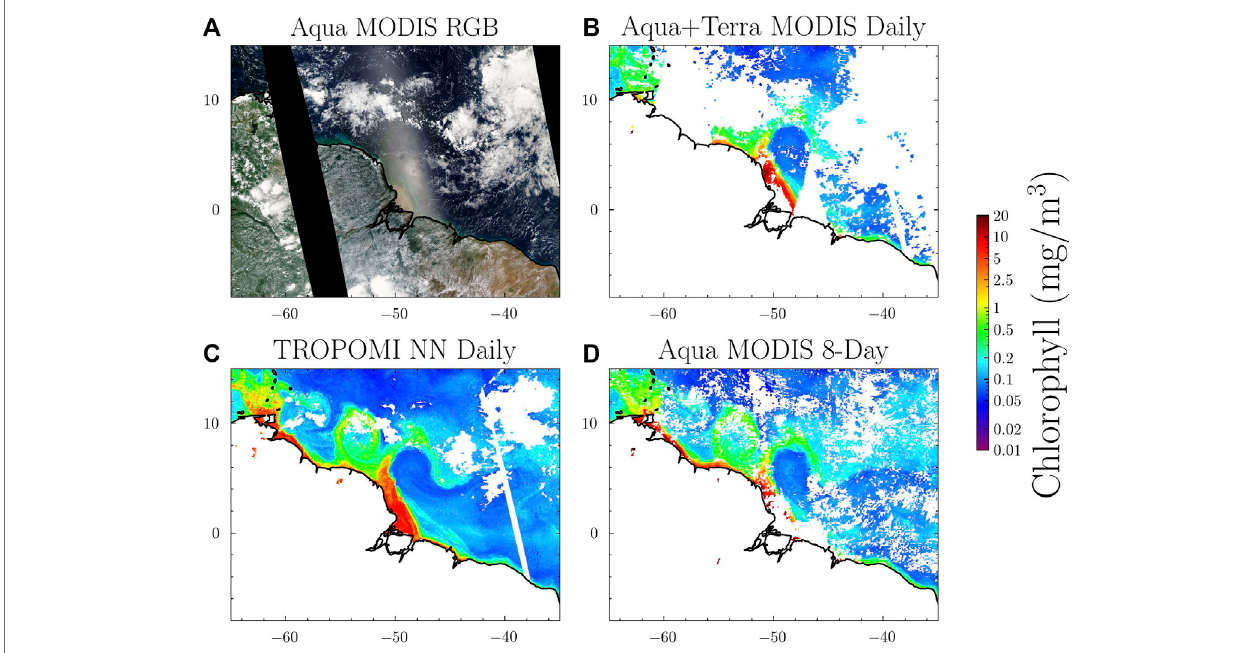
FIGURE 13 | Chlorophyll retrievals for the coast of northern Brazil on 10 October 2020. (A) shows true color image from MODIS Aqua, (B) shows MODIS-Aqua daily 4 km retrieval, bottom (C) TROPOMI machine learning – based chlorophyll, and (D) shows MODIS-Aqua 8-day composite of chlorophyll.